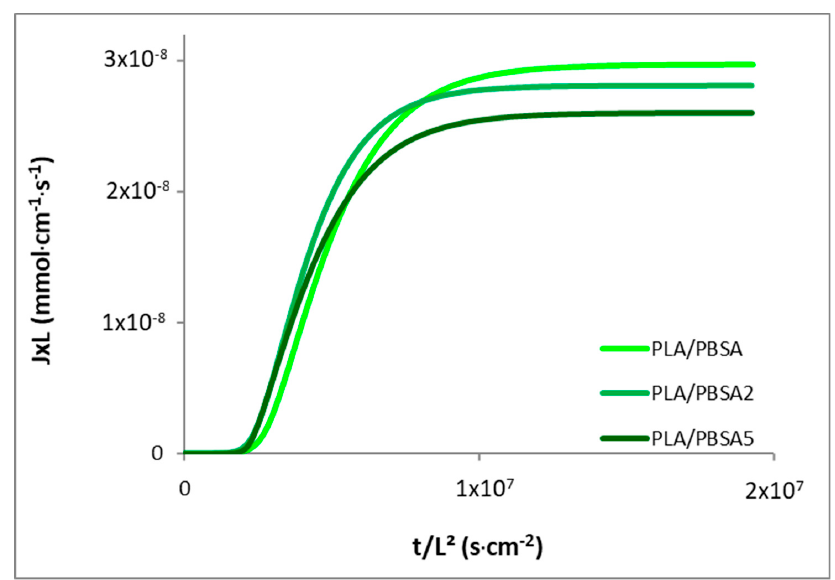
Figure 9. Reduced water permeation curves for the PLA/PBSA multilayer film and the filled PLA/PBSA multilayer films.